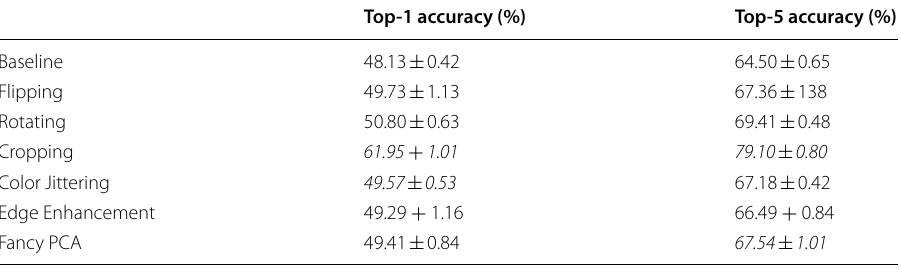
Table 1 Results of Taylor and Nitschke’s Data Augmentation experiments on Caltech101